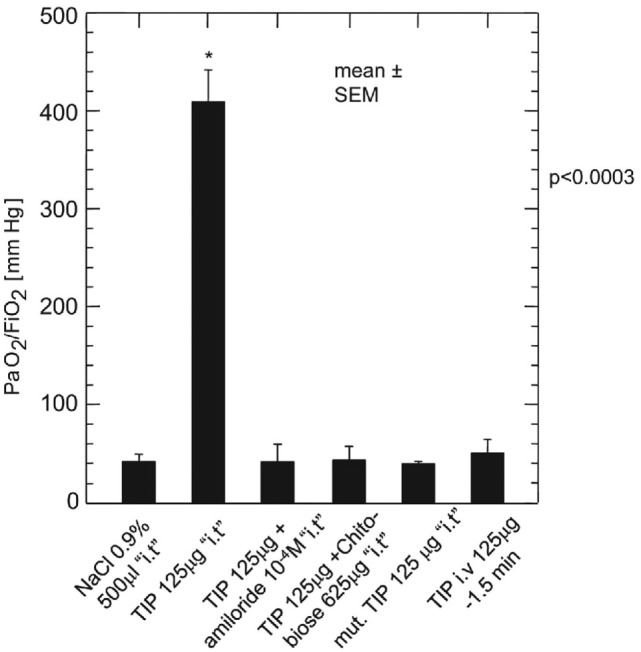
Oxygenation at 24 h after transplantation. At sacrifice, 24 h after reperfusion of the left-sided lung transplant, the PaO2/FIO2 ratio was measured after excluding the native right-sided lung by clipping the right-sided stem bronchus and right-sided pulmonary artery. The animals were tracheotomized and ventilated with an FIO2 of 1.0. The tumor necrosis factor tip peptide significantly increased gas exchange compared with all other study groups. *p < 0.003 versus NaCl. Data are mean ± SEM. i.t., intratracheally (8).